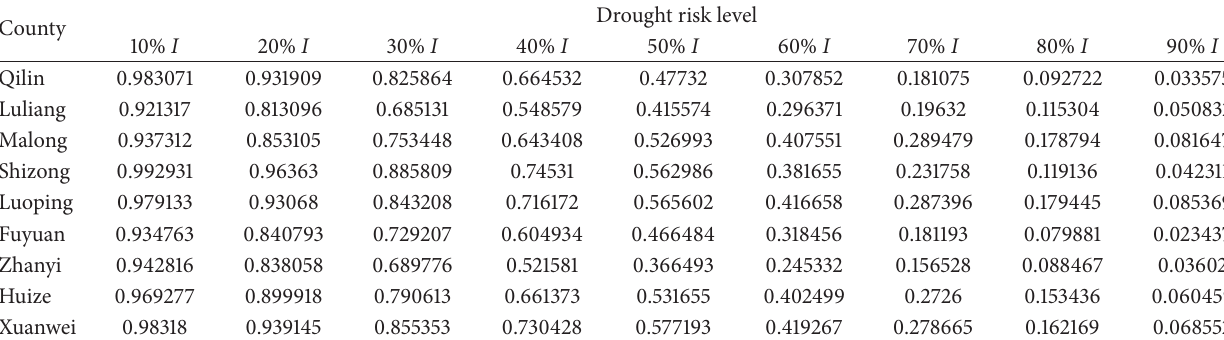
Table 4: Drought exceeding probability under different values of drought risk level in